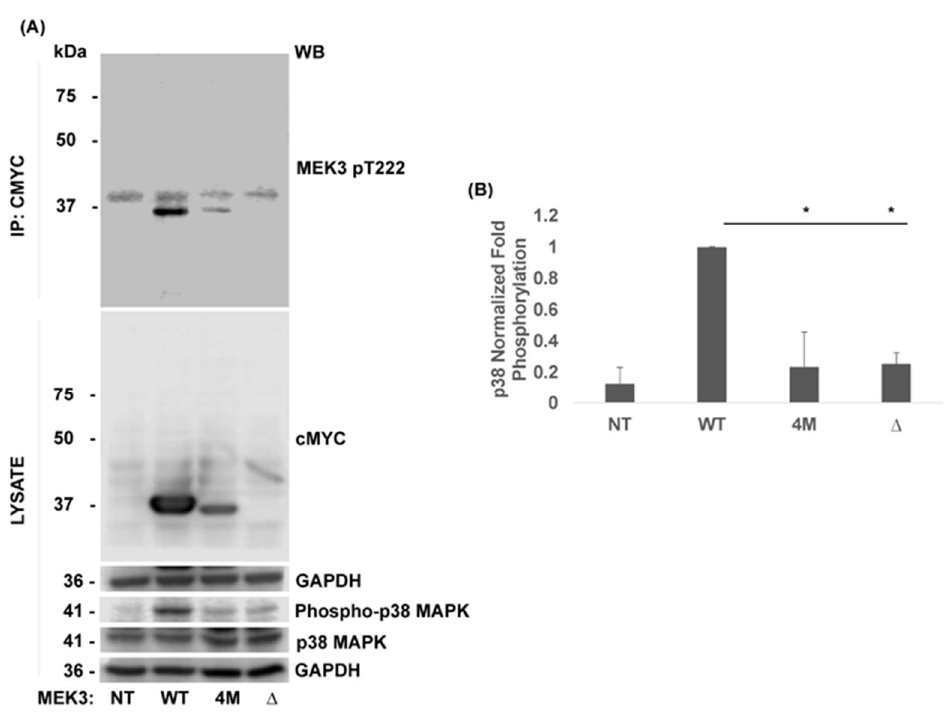
Figure 7 . MEK3 mutants disrupt auto-phosphorylation at T222 and reduce T180/Y182